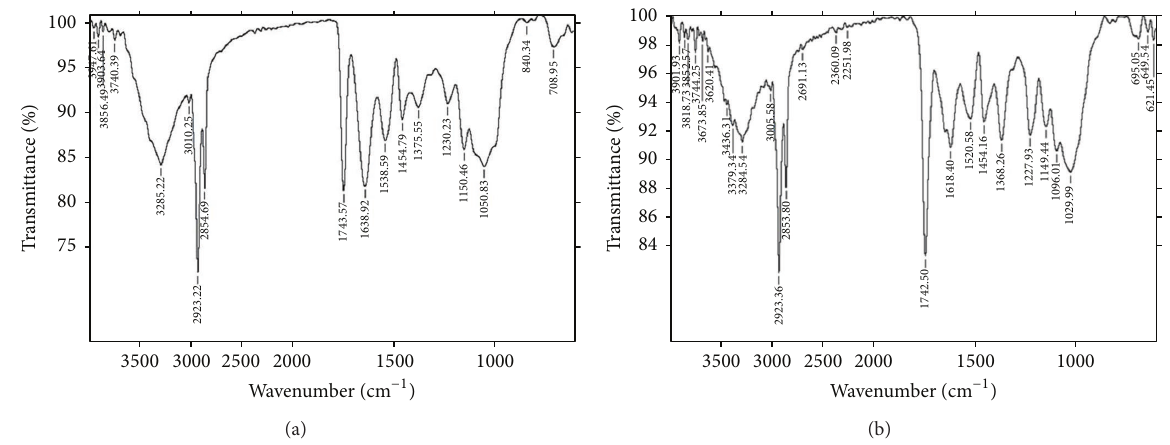
Figure 2: FTIR spectrum of (a) aqueous, (b) methanolic seed extract of Abelmoschus esculentus.